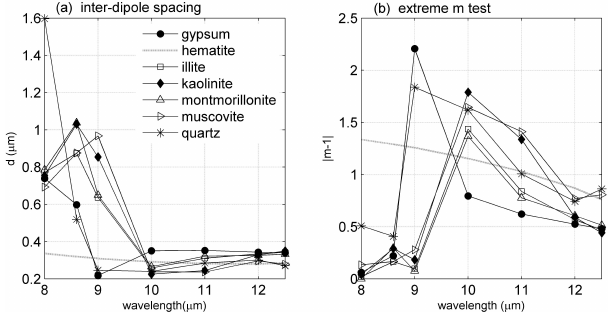
Fig. 3. DDA applicability criteria versus wavelength ( λ ) and min- eral composition for (a) maximum inter-dipole spacing d (µm) and (b) large refractive index m . See text for